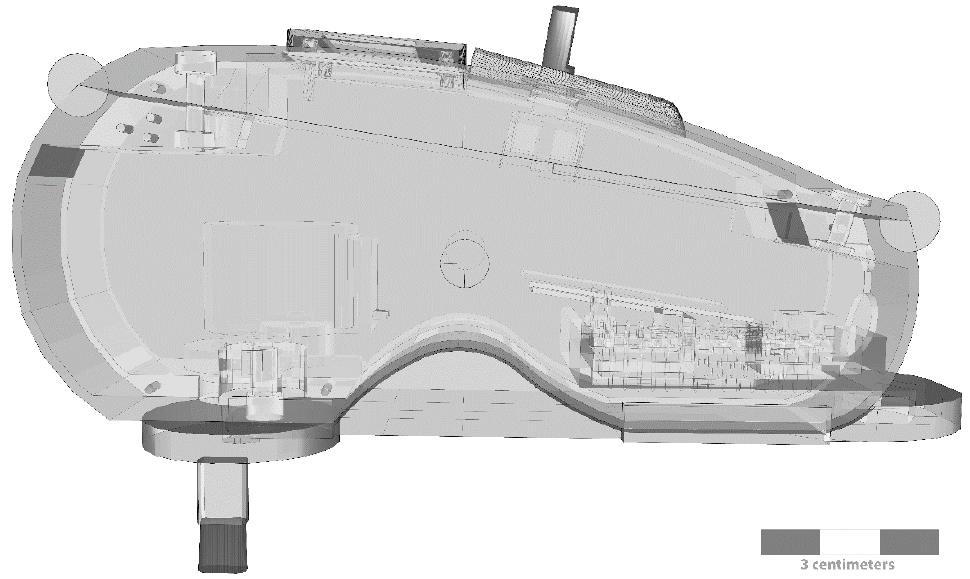
Figure 1. Interoceptive portable stimulator with a 3D-printed case and calibrated probe